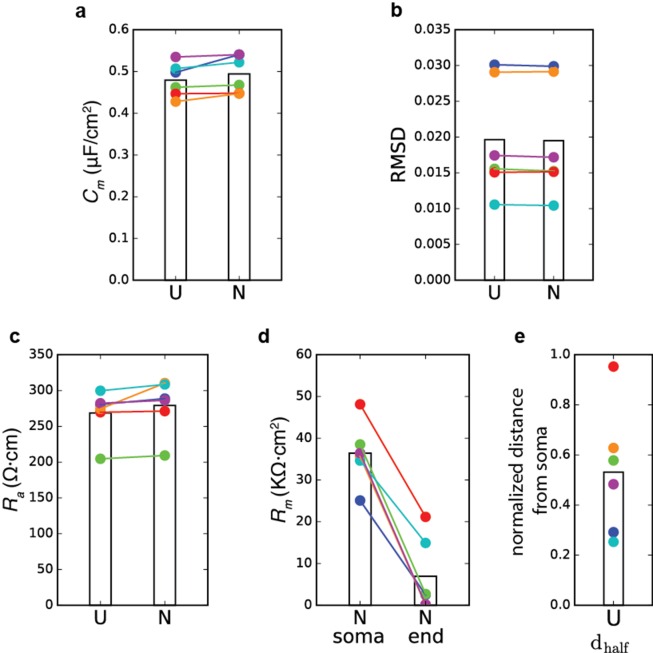
Summary of model parameters for the case of non-uniform Rm.Model transients were fitted to the experimental voltage transients as in Figure 1. Colors match the colors in Figure 1. (a) Comparison of Cmvalue for the six human models for the case of uniform Rm(U) and the case of non-uniform Rm(N). Bars show the mean value. (b) Root mean square distance between the model responses and the experimental transients. (c) Ravalues for the two cases. (d) Rm(soma) versus Rm(end) for the six models, when Rm was assumed to be non-uniform. (e) Normalized dhalf for the six models; the maximal dendritic distance in the cells was 1050 ± 178 µm.